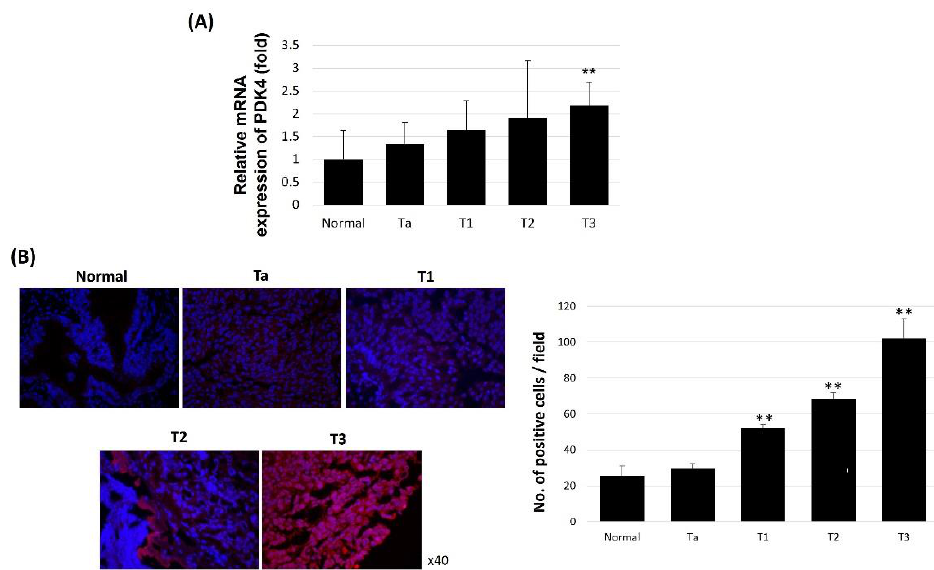
Figure 5. PDK4 expression in human bladder cancer specimen. ( A ) Relative PDK4 mRNA expression in normal and bladder cancer specimen. ( B ) Representative image of immunohisto-chemistry of PDK4 protein. All data represent means ± SD of three independent experiments (** p < 0.01 normal vs. T stages).